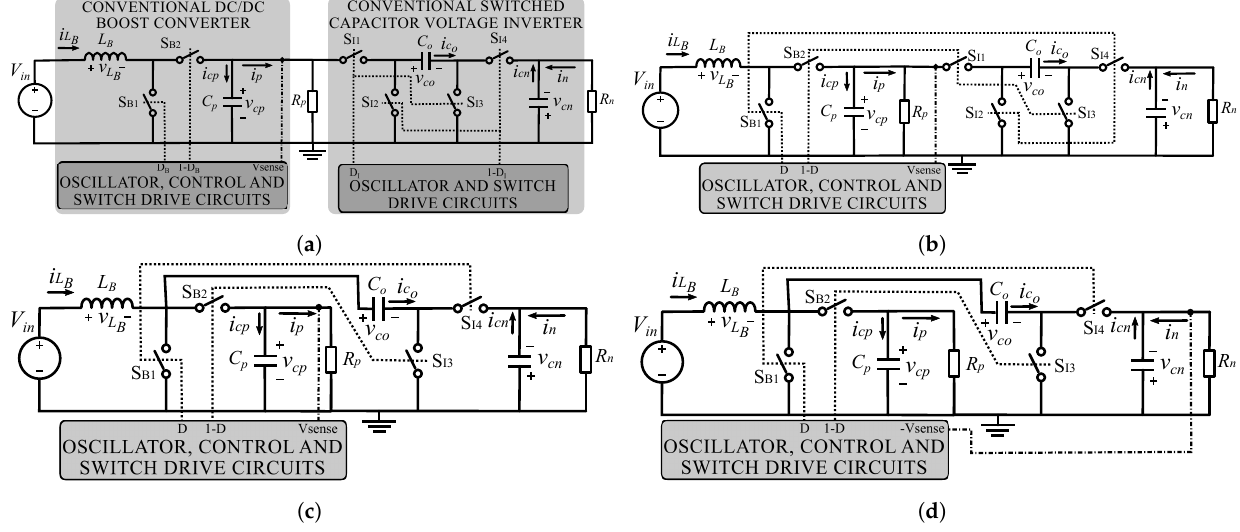
Figure 3. Optimization of the proposed cascade converters. ( a ) Step 0; ( b ) Step 1; ( c ) Step 2; ( d ) Step